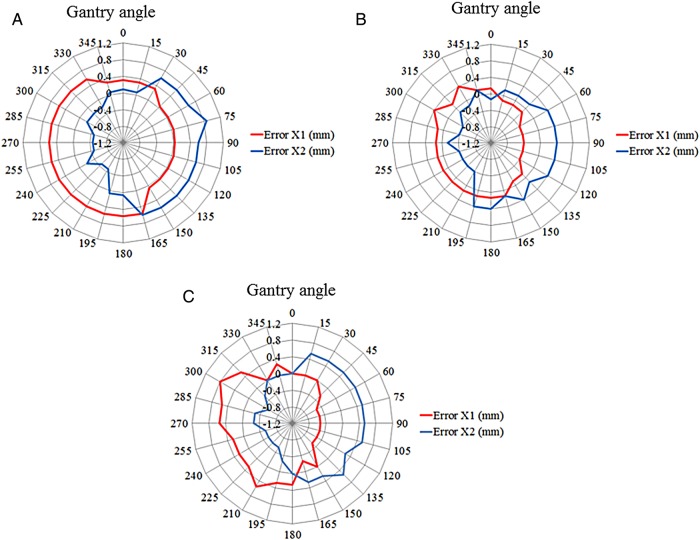
Field size errors for three nominal field sizes of (A) 5 cm × 20 cm, (B) 10 cm × 20 cm, and (C) 20 cm × 20 cm at the center MLC leaf. Nominal field sizes of each side (X1 and X2) were 2.5 cm, 5 cm and 10 cm for (A), (B) and (C), respectively. Positive values indicate a size larger than the nominal field size. Negative values indicate a size smaller than the nominal field size.